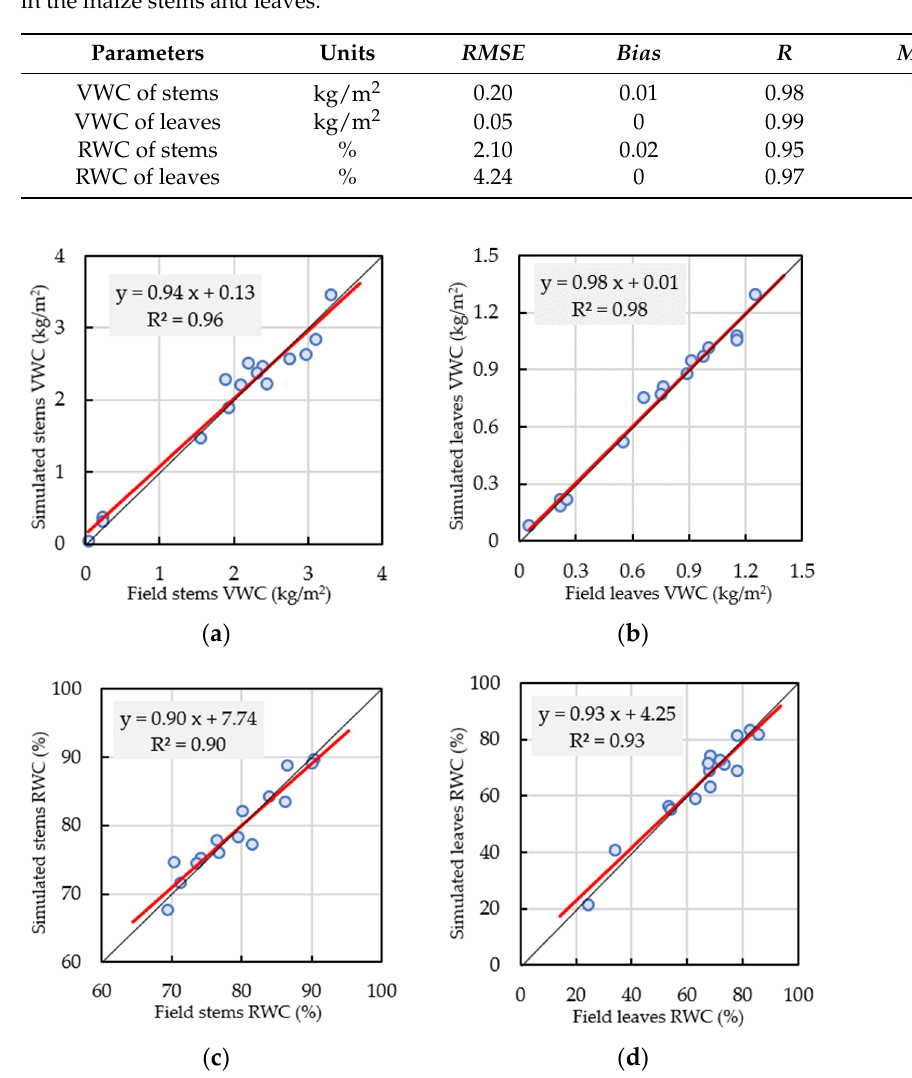
Figure 8. The comparison results of the simulated VWC and RWC of the maize leaves and stems with their measured values. ( a ) The VWC of the stems and ( b ) leaves, ( c ) the RWC of the stems and ( d ) leaves. Table 5. The evaluation indicators of the simulated and field-measured values of the VWC and RWC in the maize stems and